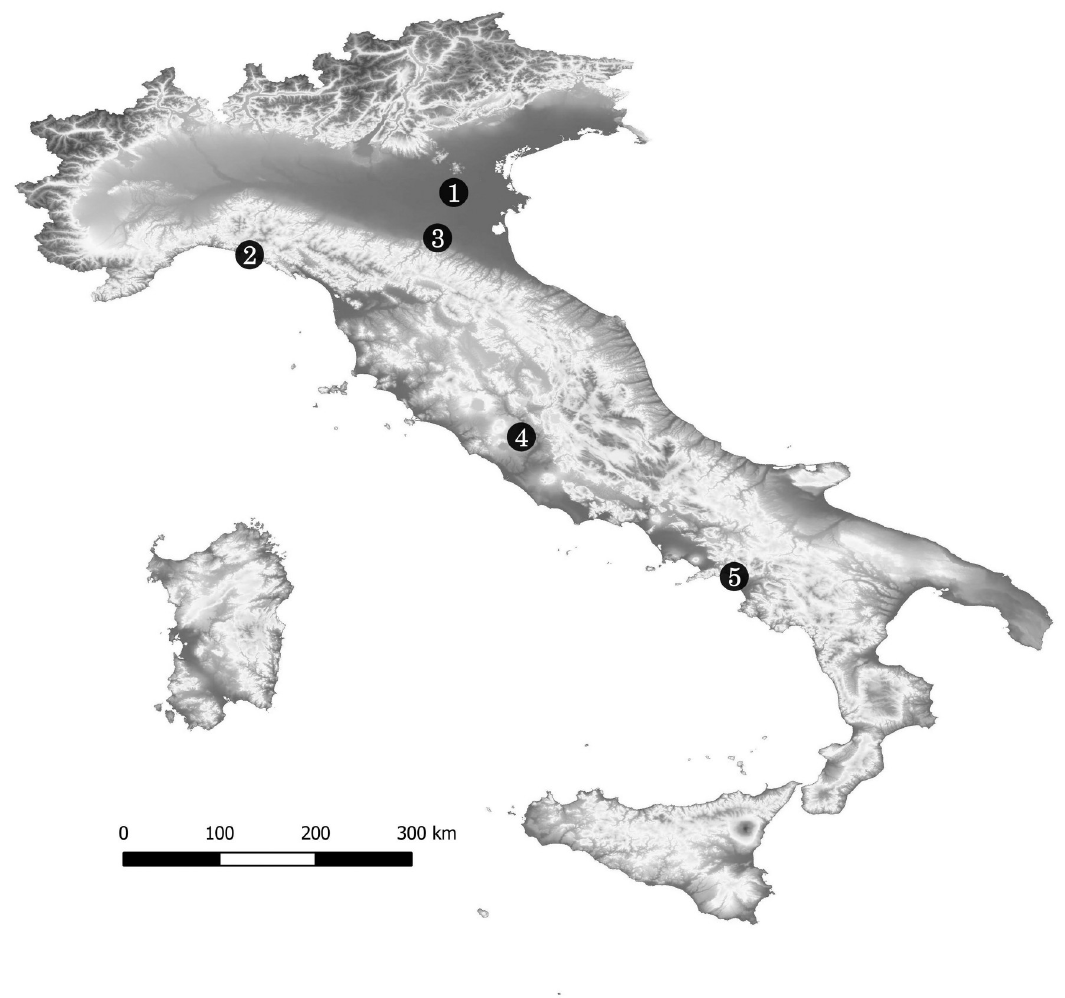
Fig 1. Geographical localization of the sites. 1. Narde di Frattesina (Fratta Polesine, Rovigo); 2. Chiavari (Genova); 3. Castenaso (Bologna); 4. Narce (Faleri, Viterbo); 5. Pontecagnano (Salerno). The map is constructed by using public domain wms data downloadable from http://www.pcn.minambiente.it/mattm/servizio-wms/ under a CC BY license, with permission from Geoportale